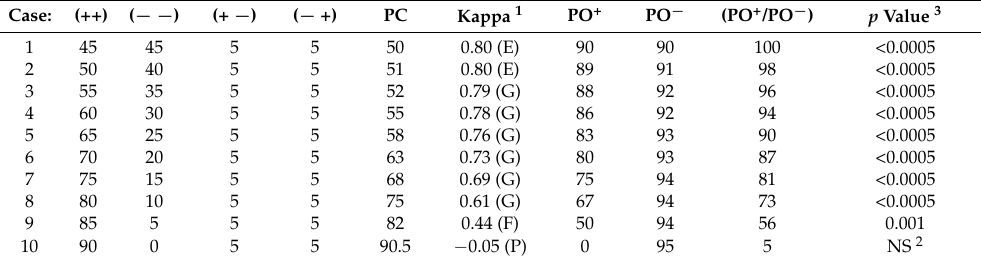
Table 6. Relationship between the Reliability and Accuracy of Pairs of Hypothetical Tasters Judging Whether a Wine is Filtered (+) or Not Filtered ( − ) When the Tasters Are in 90%